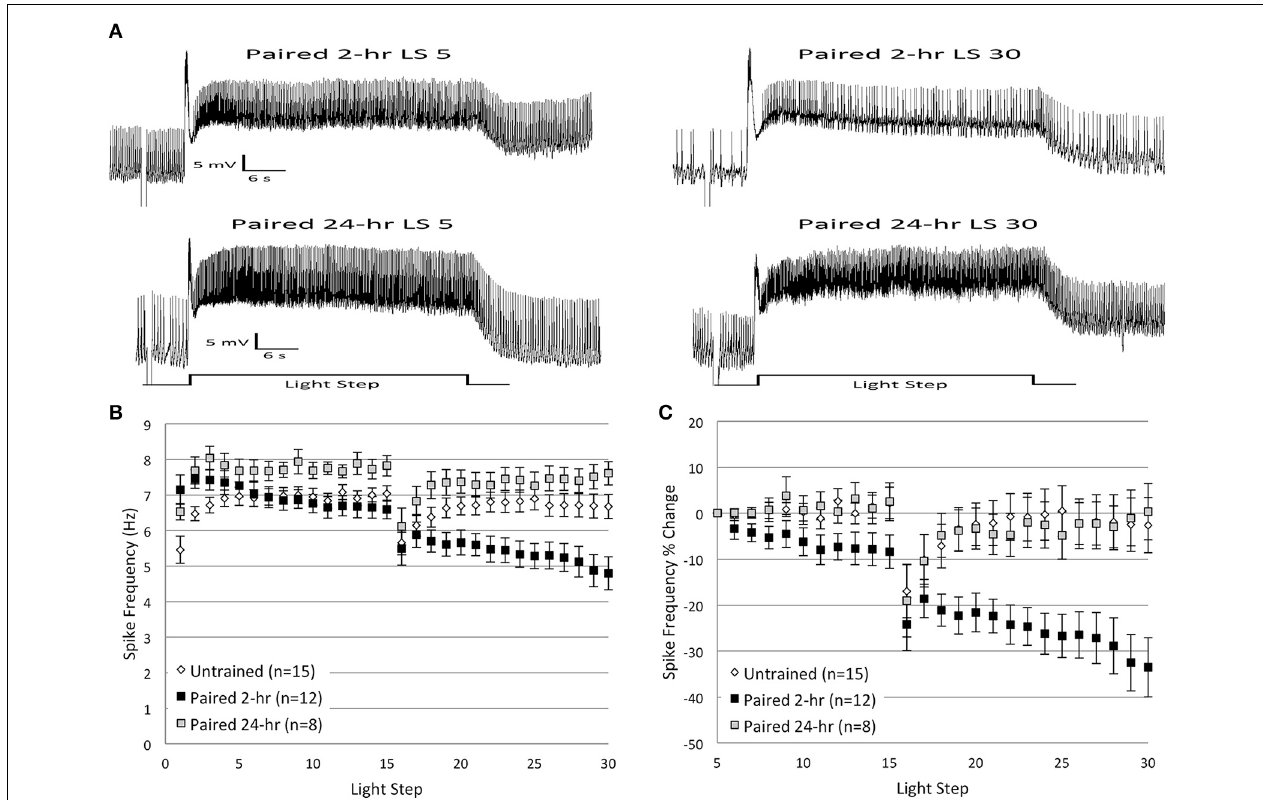
FIGURE 12 | Delayed in vitro extinction failed to reduce Type B cell spike frequencies. (A) Representative light responses recorded from Type B photoreceptors from paired-trained animals either 2h ( Paired 2-h ; top trace) or 24h ( Paired 24-h ; bottom trace) after the end of paired conditioning. The Paired 24-h cell did not show any appreciable decline in spike frequency over the course of 30 LSs, while the Paired 2-h cell showed a significant decline. (B) Summary spike frequency data of Type B cells across 30 LSs from Untrained or Paired animals, both 2 and 24h after conditioning. Paired 24-h cells showed increased spike frequencies compared to Untrained control and Paired 2-h cells during LSs 1–30, and